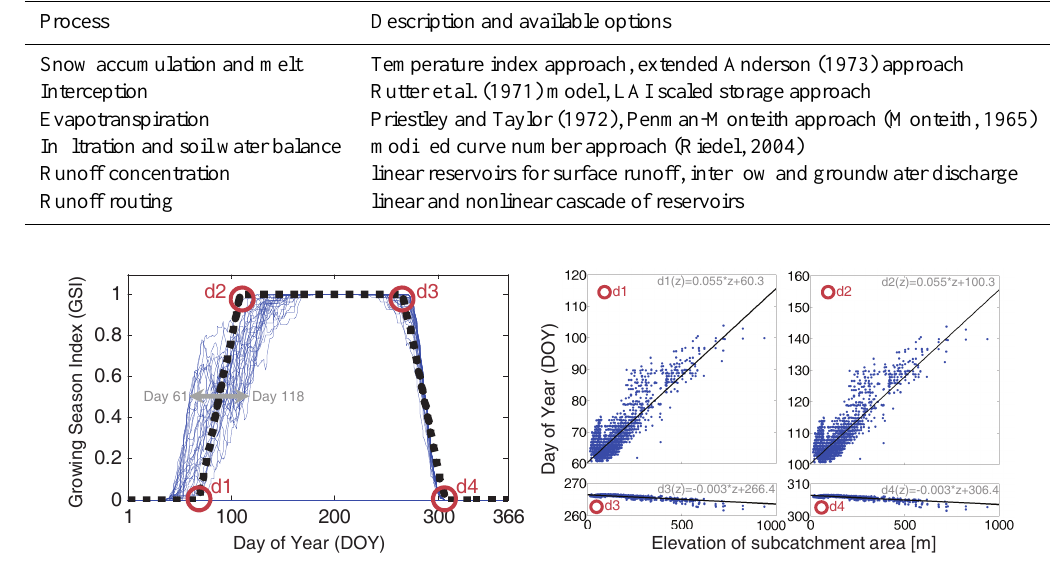
Fig. 4. Left panel: GSI courses of individual years and fitted mean GSI courses for an example sub-catchment. The points d n separate the mean course into 4 linear ranges which can easily be calculated from elevation. Right panel: Values of d n were calculated for each sub-catchment in south-eastern Lower Saxony (4500 in total). Regression functions were derived for each d n by plotting day of year for d n against sub-catchment elevation.